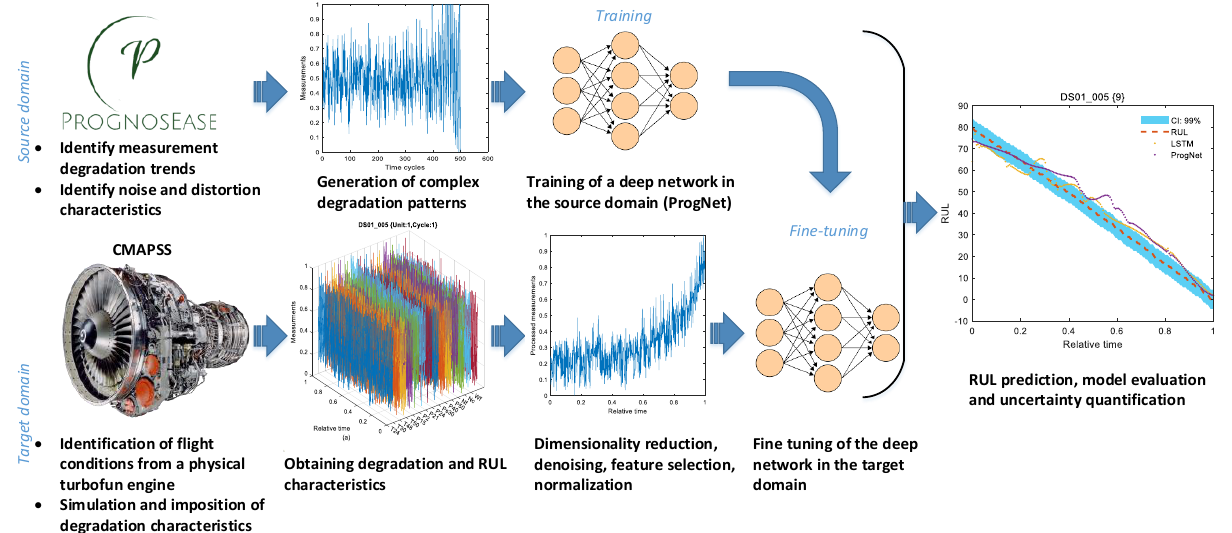
Figure 4. The predicting RUL proposed methodology.